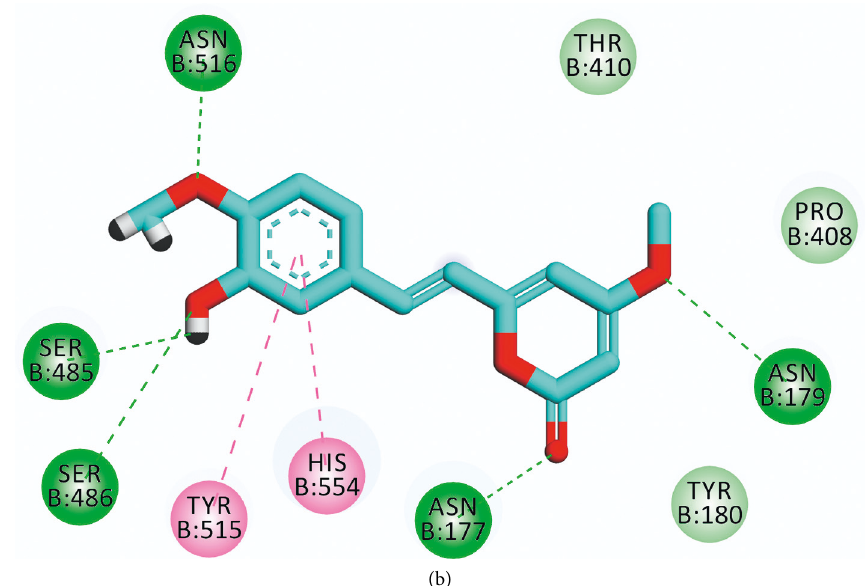
Figure 6: (a) 3D and (b) 2D images of the docked compound 533 into the active site of SARS-CoV-2 helicase.